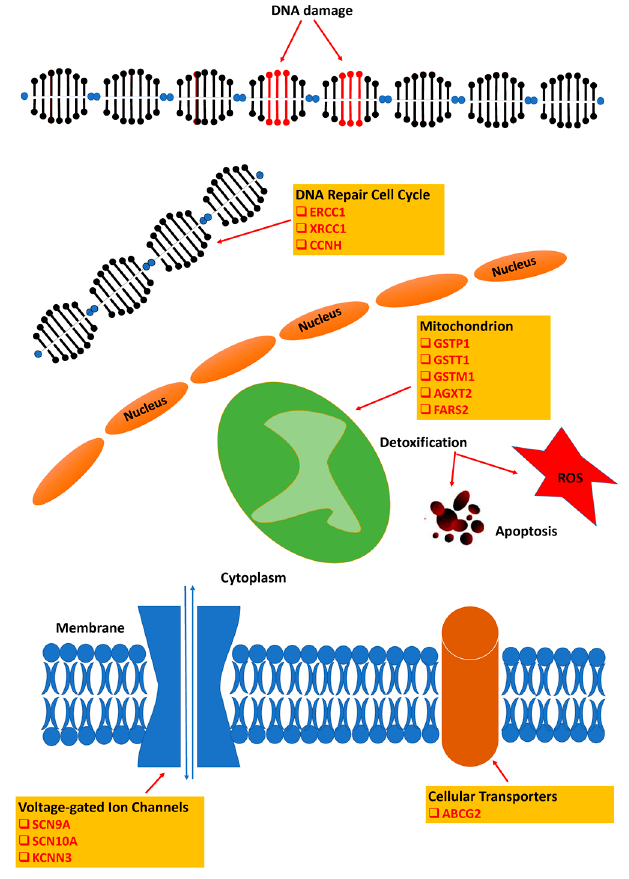
Figure 3. Cellular processes and main candidate genes implicated in oxaliplatin-induced neurotox-